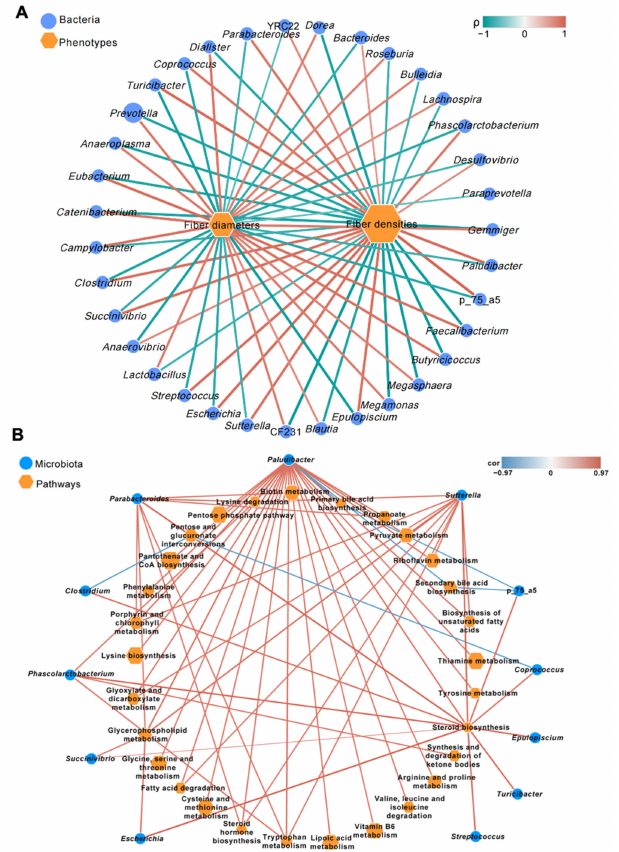
Figure 5. Correlation networks showed the relationships between differential microbial genera and skeletal muscle phenotypes ( A ) or microbial KEGG level-3 metabolic pathways ( B ) of pigs. ( A ) The node size and color (blue circle: differential microbial genera; orange hexagon: differential skeletal muscle phenotypes) are proportional to the mean relative abundance in the respective population. The lines’ width and color (red: positive; green: negative) are proportional to the correlation strength. Only significant correlations (R > 0.60 or < − 0.60; p < 0.05) are displayed. ( B ) The node size and color (blue circle: differential microbial genera; orange hexagon: differential microbial metabolic pathways) are proportional to the mean relative abundance in the respective population. Only significant correlations (R > 0.75 or < − 0.75; p < 0.05) were